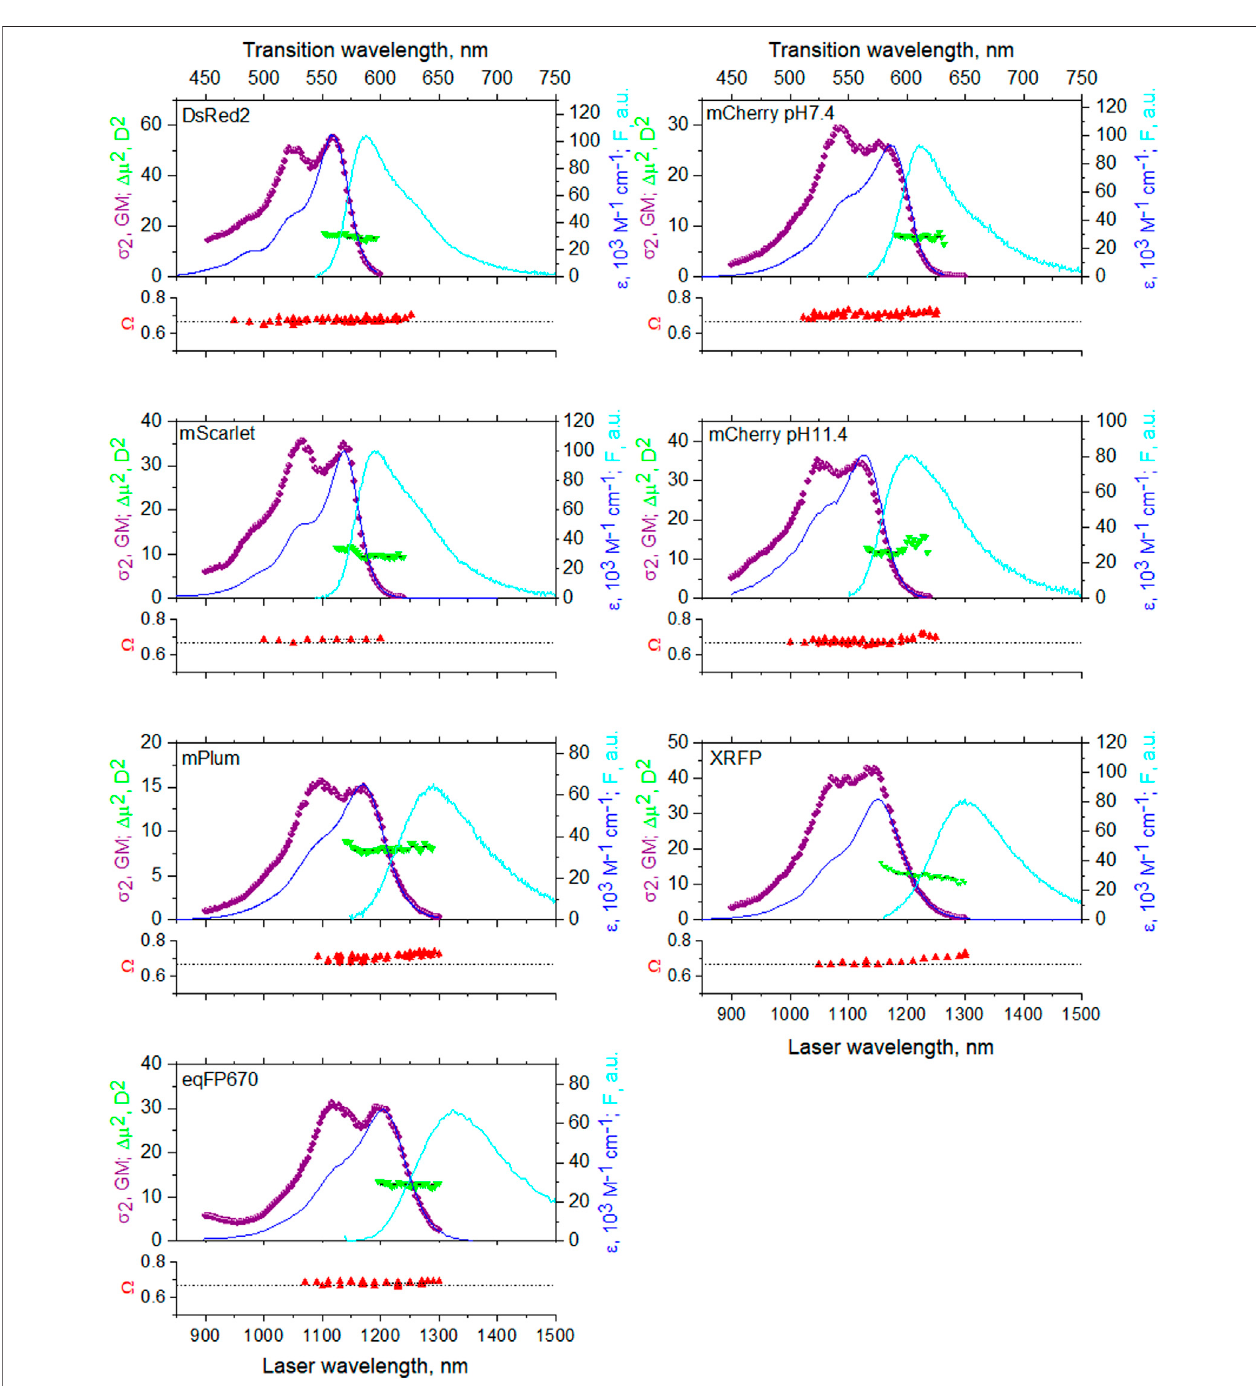
FIGURE 5 | Top panels: one-photon absorption (dark blue line, right y -axis), fl uorescence normalized to one-photon absorption peak (cyan line, right y -axis), and two-photon absorption (purple symbols, left y -axis) spectra in the region of the S 0 - > S 1 transition. Green triangles represent the calculated Δ μ 2 values (left y -axis) as a function of excitation wavelength. Bottom panels show the two-photon polarization ratio Ω (red symbols) as a function of excitation wavelength. Horizontal dashed line represents a limiting case of Ω (cid:2) 2/3, c (cid:2) 0. The top x -axis corresponds to transition wavelength, that is the same for both 1P and 2P excitation, and the bottom x -axis corresponds to laser wavelength, used for 2P